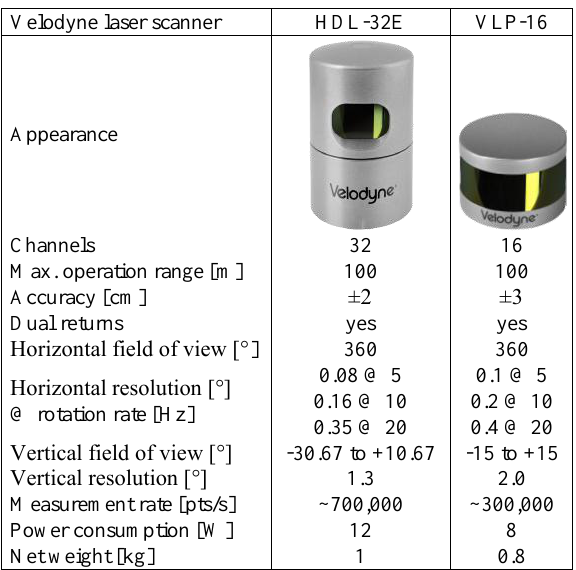
Table 2. Parameters of two Velodyne